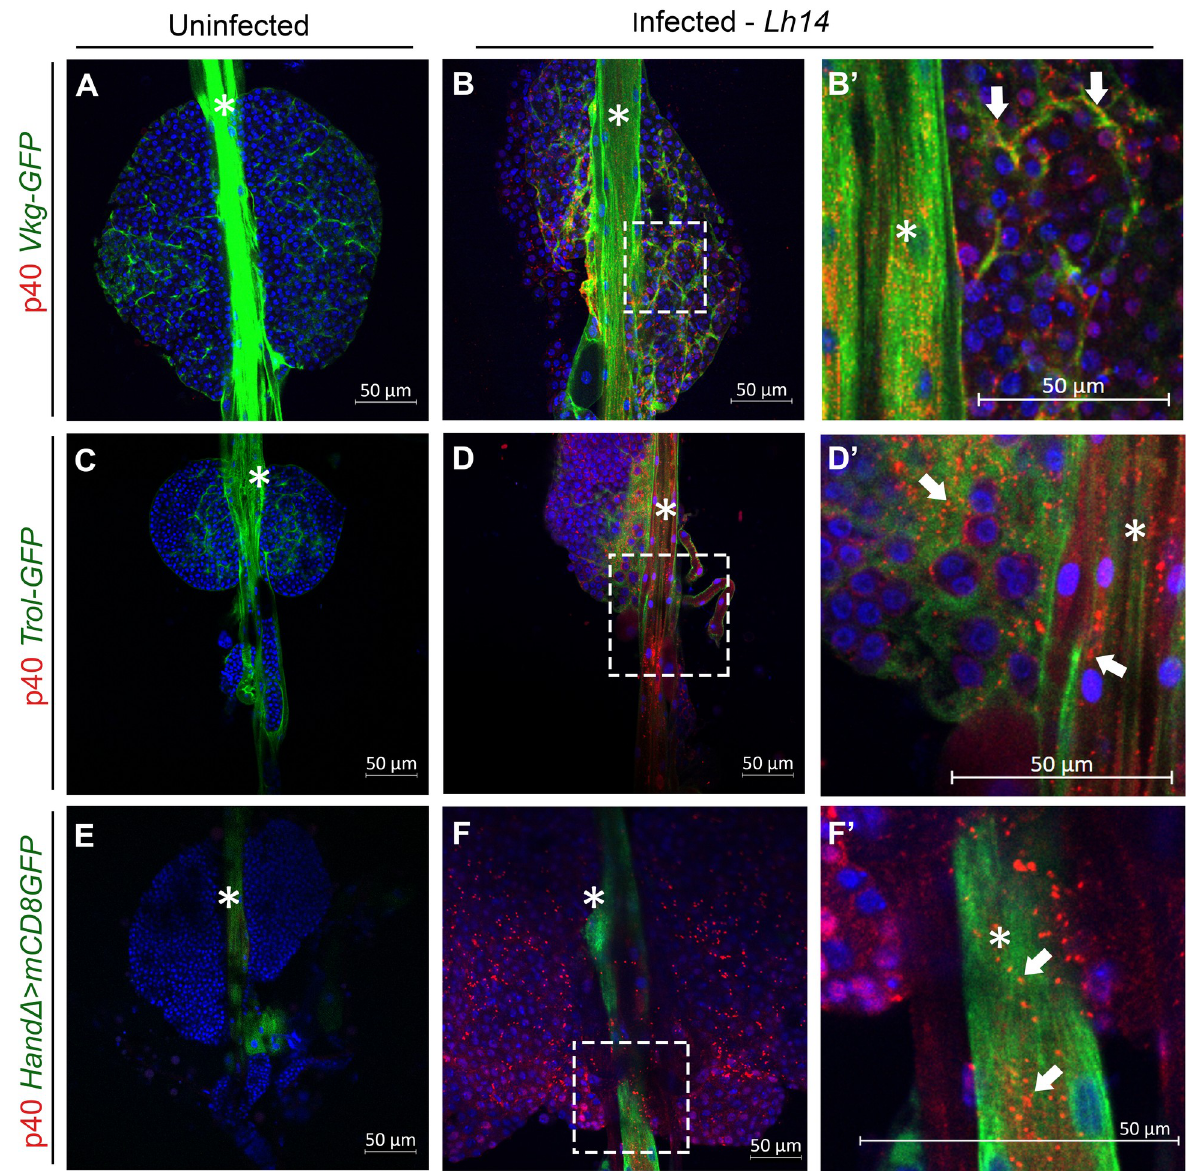
Fig 2. Lh EVs associate with basement membrane proteins. ( A-B ) Vkg-GFP lymph glands. ( A ) GFP marks Collagen IV in the dorsal vessel and around lobe clusters. ( B-B’ ) Lh -infected gland shows extensive EV puncta co-localized with GFP in the dorsal vessel ( � ), and in between lobe clusters. Punctate, cytoplasmic staining in many cells throughout the anterior lobes ( B, B’ , arrows) is also observed. ( C-D ) Trol-GFP lymph glands. GFP marks Trol/perlecan distribution in na ï ve ( C ) and Lh -infected ( D ) animals. Co-localization of Trol-GFP and EV puncta is observed ( D, D’ , arrows). ( E-F ) Hand Δ > mCD8GFP marks the cells of the dorsal vessel. ( E ) An intact lymph gland from a na ï ve animal. ( F, F’ , arrows) EV signal localizes with the GFP signal in the cardiomyocytes.